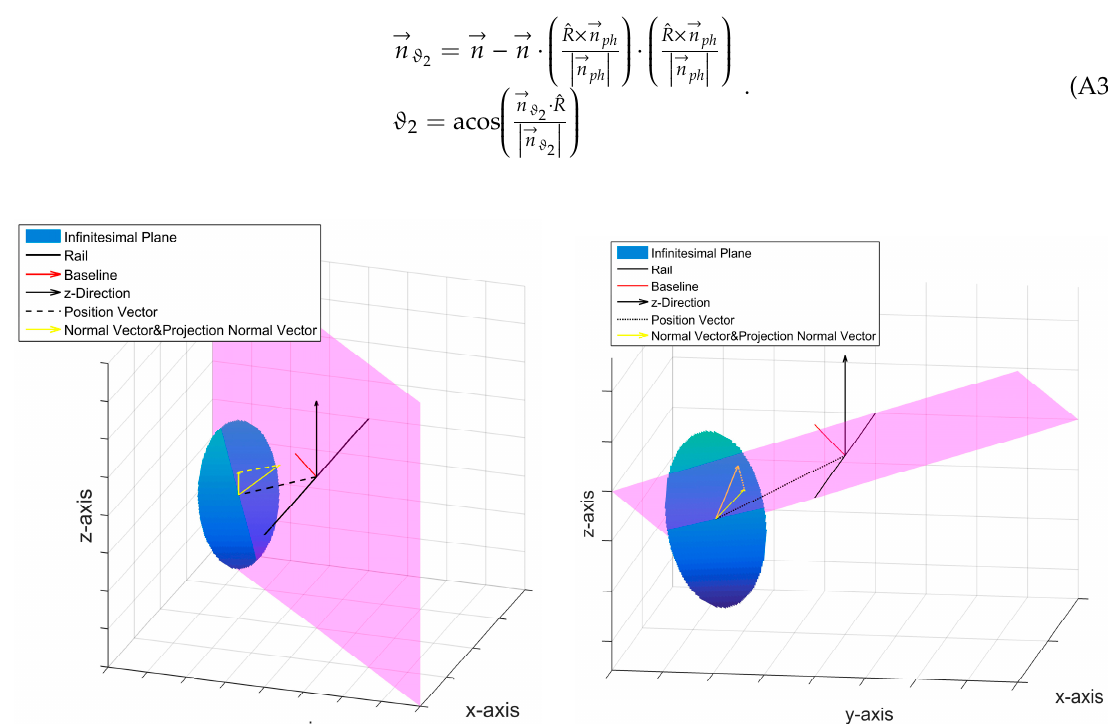
Figure A1. Sketch map of the geometry relationship about ϑ 1 ( left ) and ϑ 2 ( right